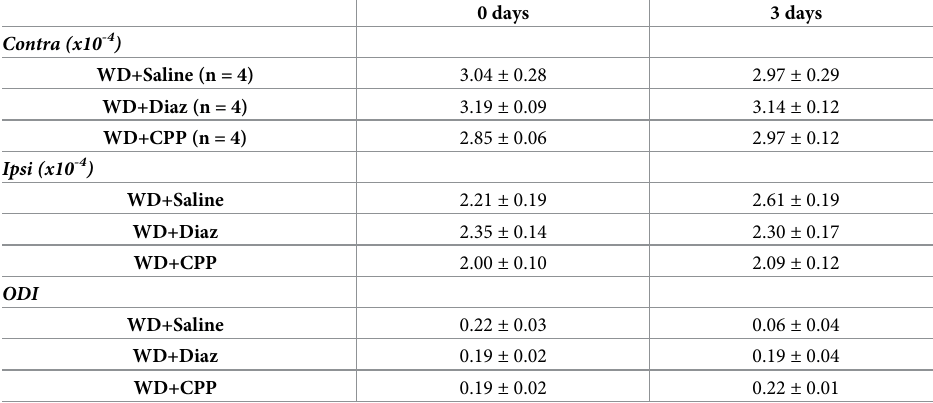
Table 2. The effects of diazepam and CPP administration on cross-modally induced V1 activity changes after WD. Data are presented as means ±